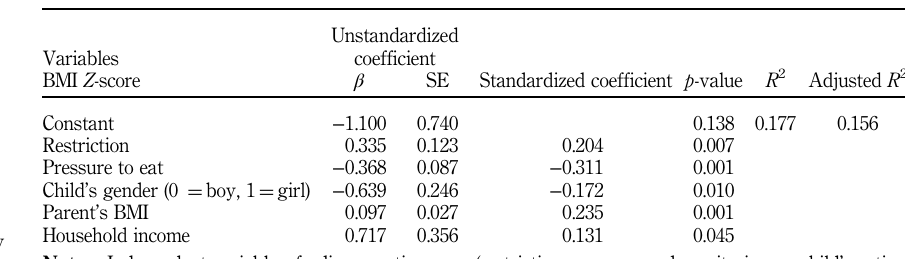
Table V. Household food security and parental feeding practice provided to